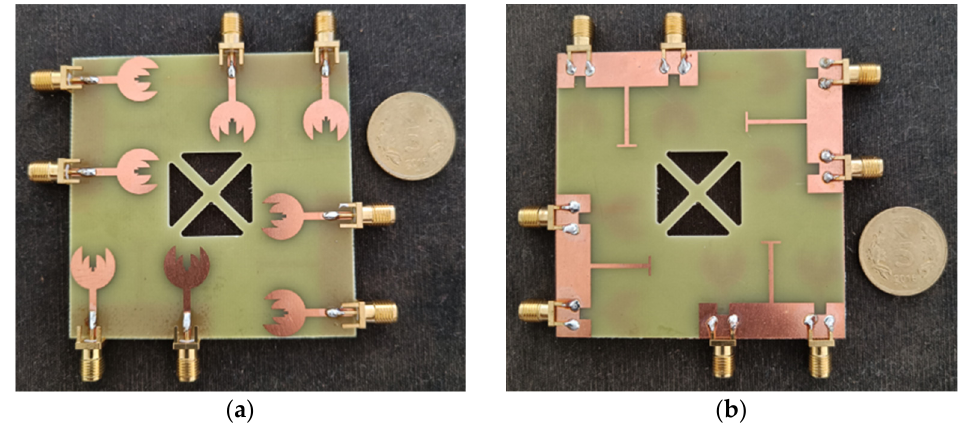
Figure 12. Fabricated prototype: ( a ) front view and ( b ) rear view.